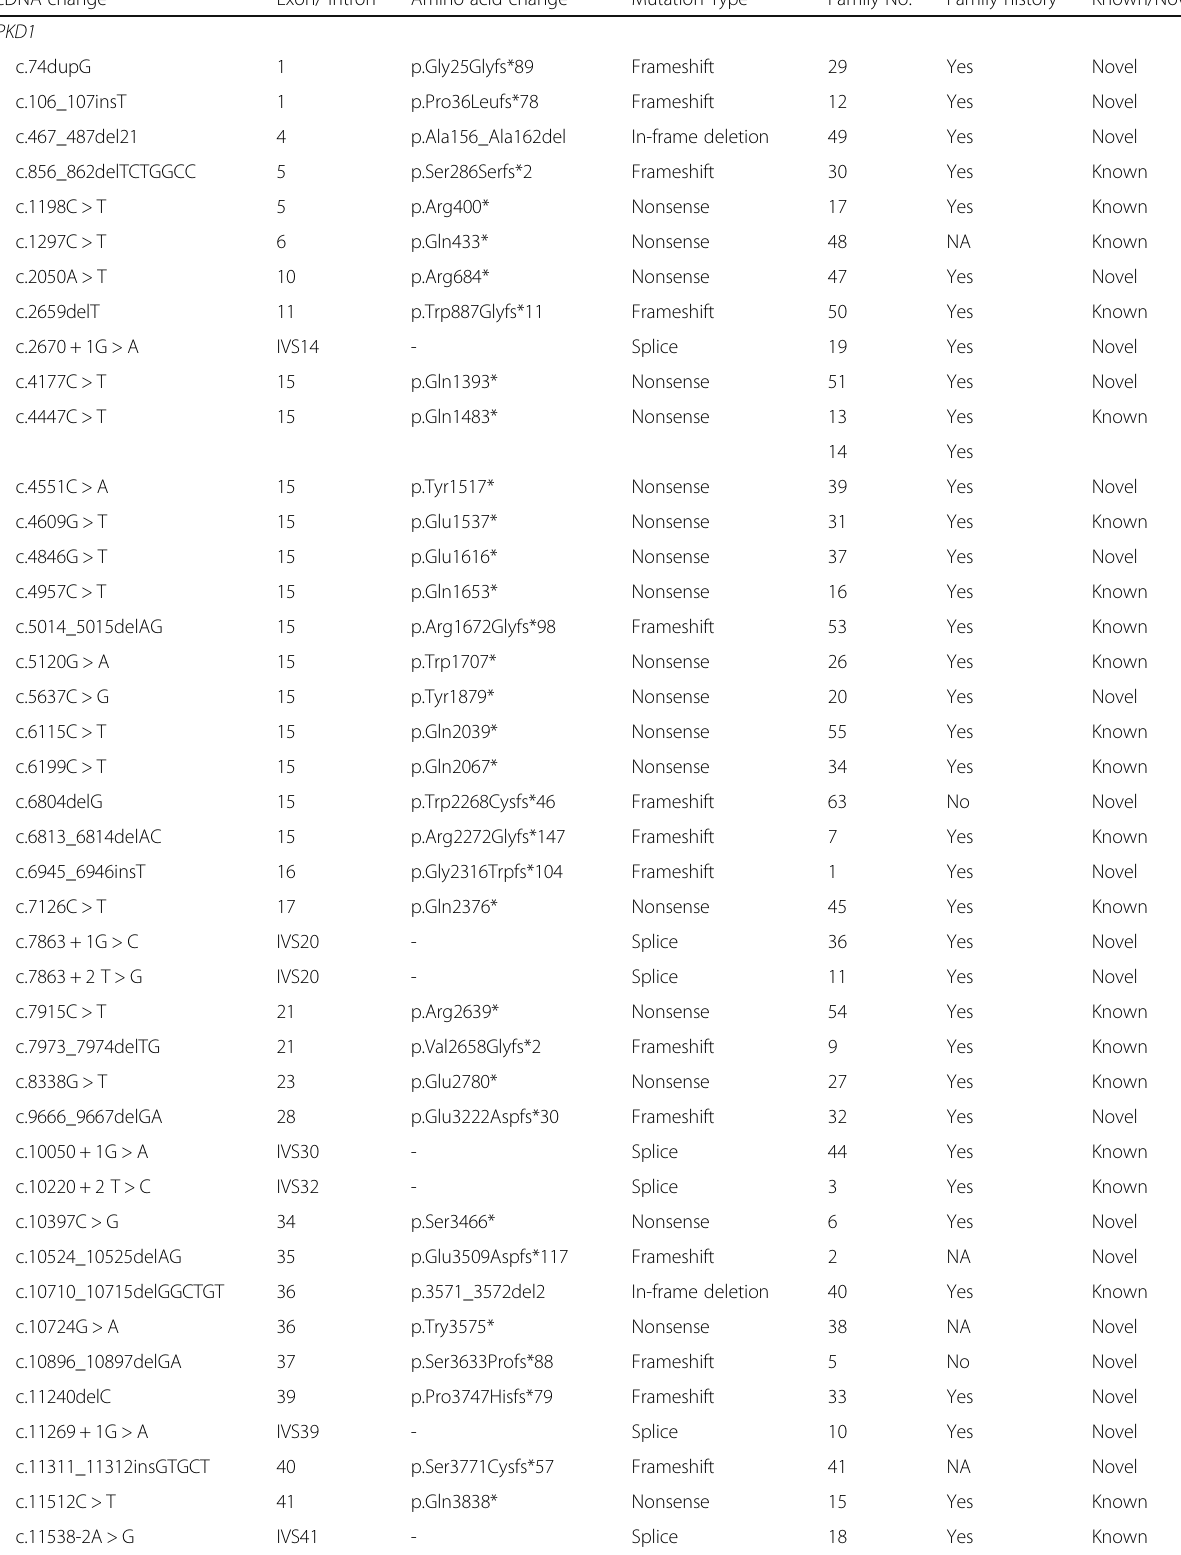
Table 1 Defnitely pathogenic mutations in PKD1 and PKD2 identified in this study cDNA